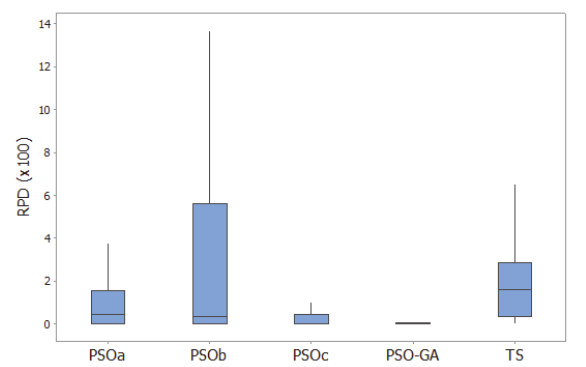
Fig. 4. Comparison of meta-heuristics: